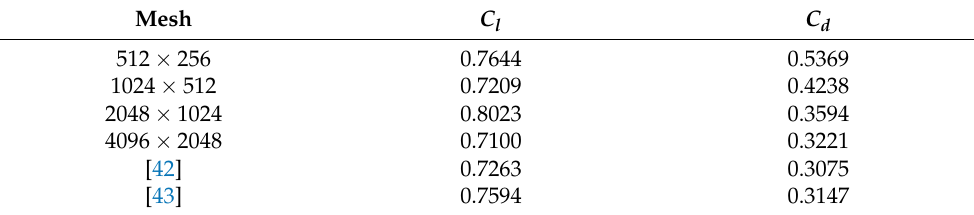
Table 2. Influence of mesh refinement: mean coefficients C l e C d , obtained in the interval time t ∗ = [ 70 : 100 ] , for α = 16 ◦